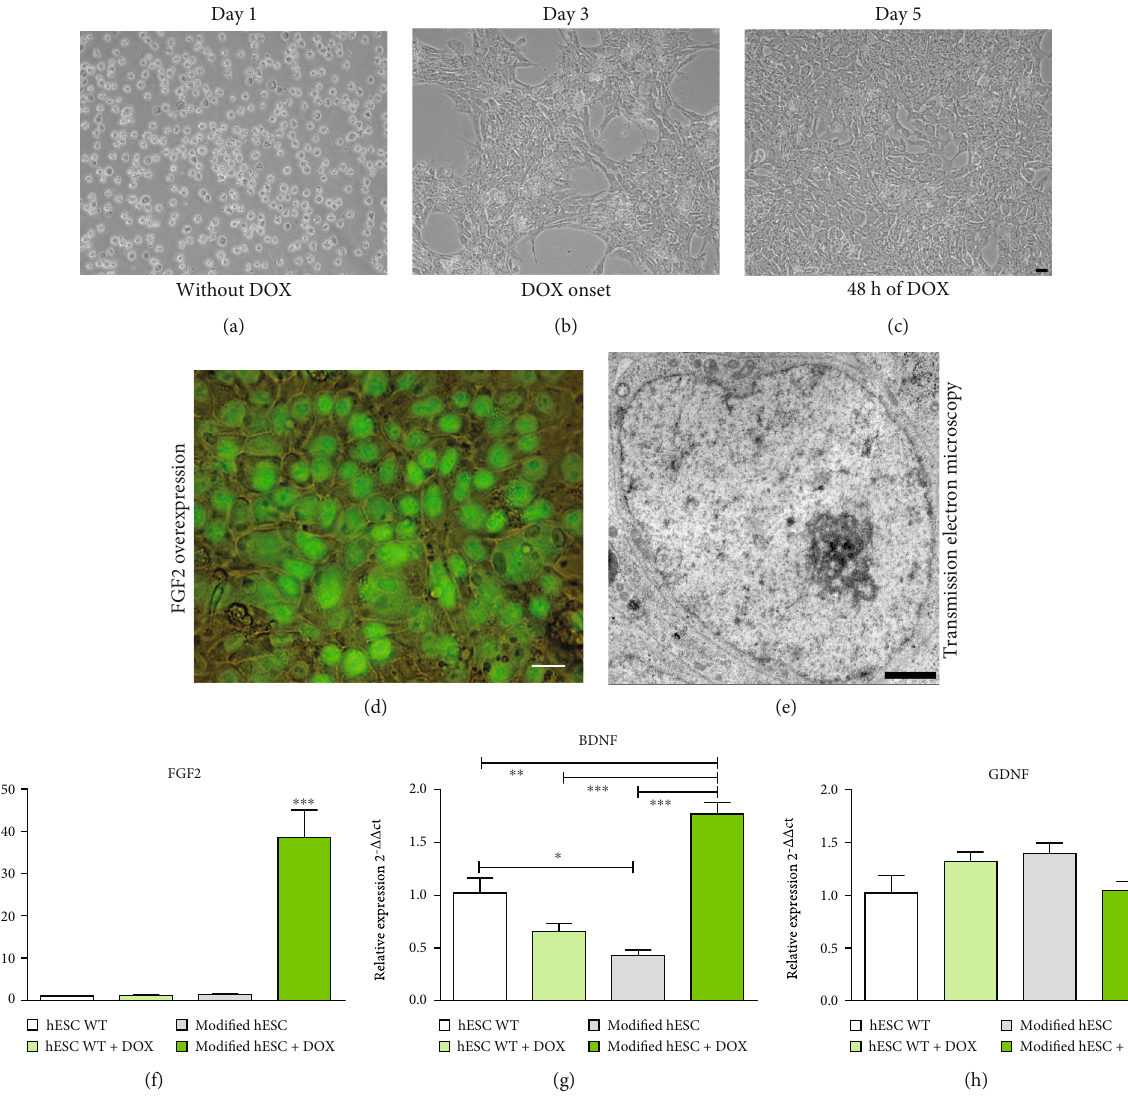
Figure 1: (a – c) Cultivation of bioengineered human embryonic stem cell (hESC) clones over time. The formation of the cell monolayer (con fl uence) was observed on the fi fth day (c). The cells were attached to a matrix (Matrigel) and expanded rapidly in their own medium, and they formed colonies and/or aggregates. Bright fi eld. Scale bar = 10 μ m . (d) Clones were induced to overexpress FGF2 at 48 hours after doxycycline administration. Practically all cells were fl uorescent green (GFP+), which indicates that hESCs were activated by DOX and then overexpressed FGF2. Phase contrast. Scale bar = 25 μ m . (e) A single bioengineered hESC was observed under electron microscopy, enabling visualization of the large nucleus, very evident nucleolus, and euchromatin, indicating high metabolic activity. Scale bar = 1 μ m . (f – h) Relative expression of basic fi broblast growth factor (FGF2), brain-derived neurotrophic factor (BDNF), and glial cell line-derived neurotrophic factor (GDNF) mRNA in vitro . (f) The transcript levels for FGF2 were over 35-fold higher when modi fi ed hESCs were induced by doxycycline. Modi fi ed hESCs not treated with doxycycline and wildtype cells treated or not treated with doxycycline presented nearly undetectable expression of FGF2. (g) Compared with other groups, the transcript levels for BDNF were signi fi cantly higher when modi fi ed hESCs were induced by doxycycline. (h) The transcript levels for GDNF were not signi fi cantly di ff erent between groups. Mean ± SEM . ∗∗∗ p < 0 : 001 . hESCs: human embryonic stem cells; WT: wildtype; DOX: